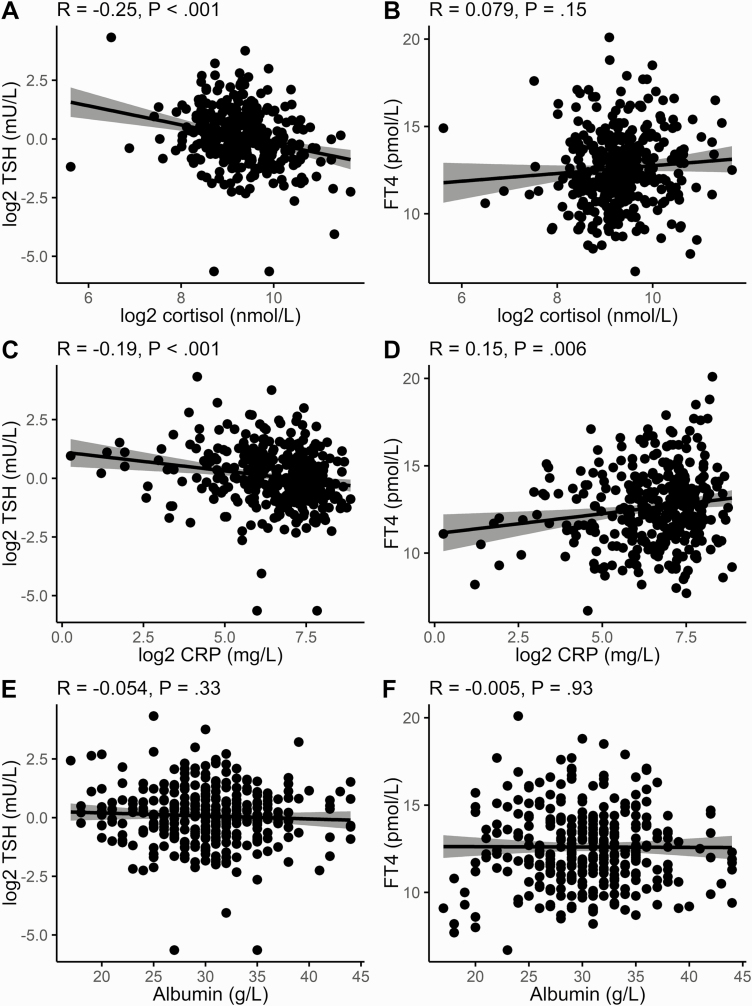
Correlations of free thyroxine (T4) and log-transformed thyrotropin (TSH) with cortisol, C-reactive protein (CRP), and albumin in coronavirus disease 2019 (COVID-19)–positive patients. Scatterplots of A, C, and E, log-transformed TSH, and B, D, and F, free T4 on the y axes are plotted against A and B, log2 cortisol, C and D, log2 CRP, and E and F, albumin on the x axes. Pearson correlation is shown at the top with its associated P value. Regression line (black line) and 95% CI (gray shading) are plotted.